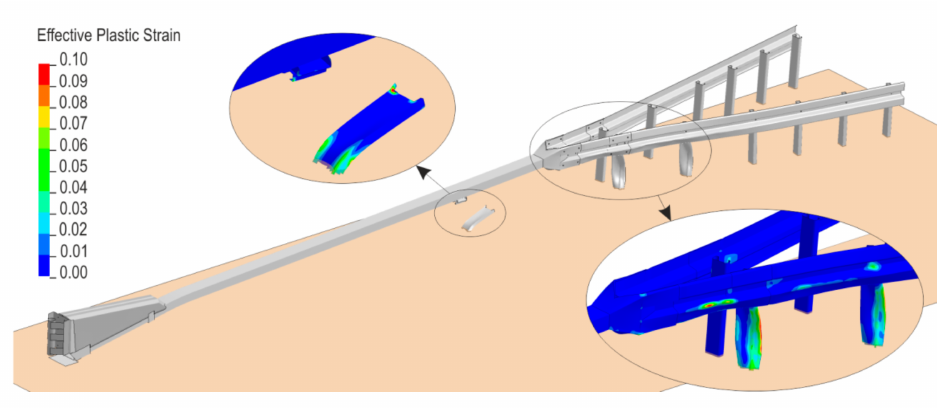
Figure 7. Comparison of the real test ( top ) with the numerical simulation ( bottom ), front view.